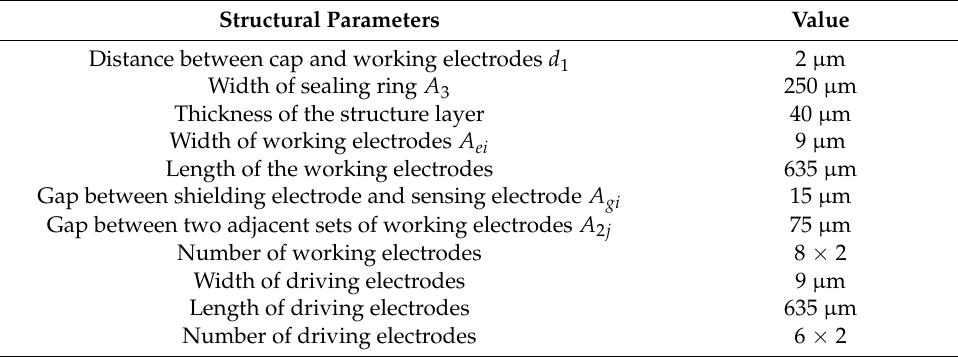
Table 1. Key parameters of the proposed